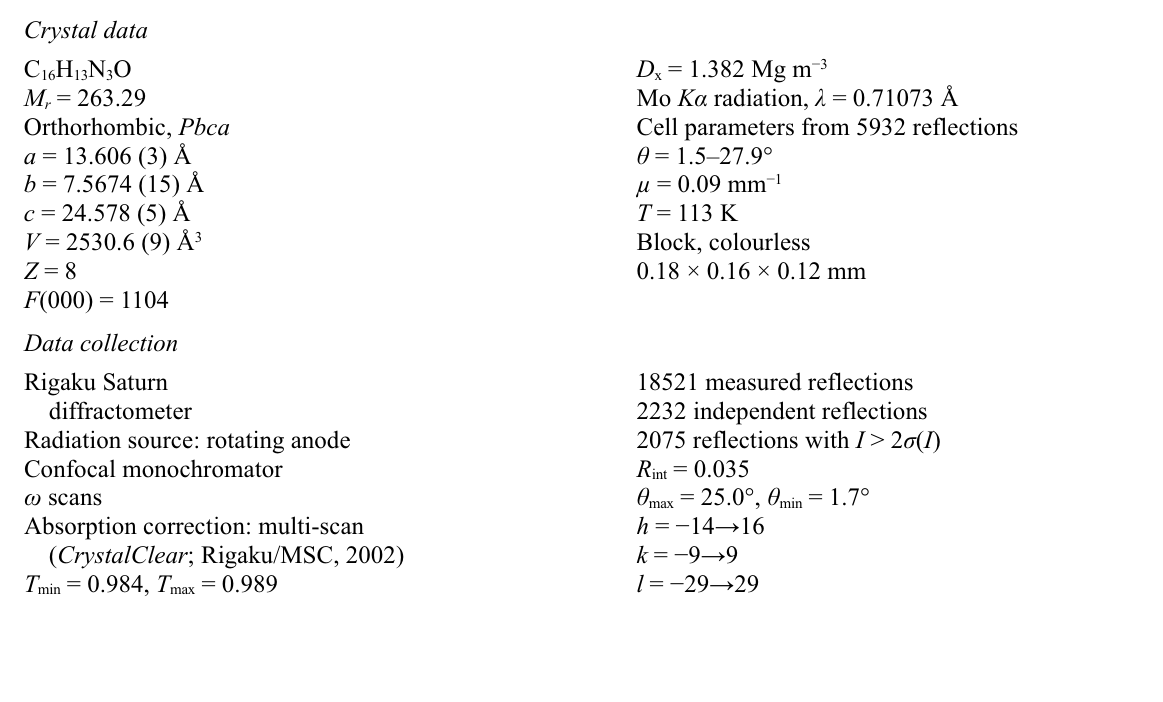
The packing diagram of the title compound. Intermolecular hydrogen bonds are shown as dashed lines.